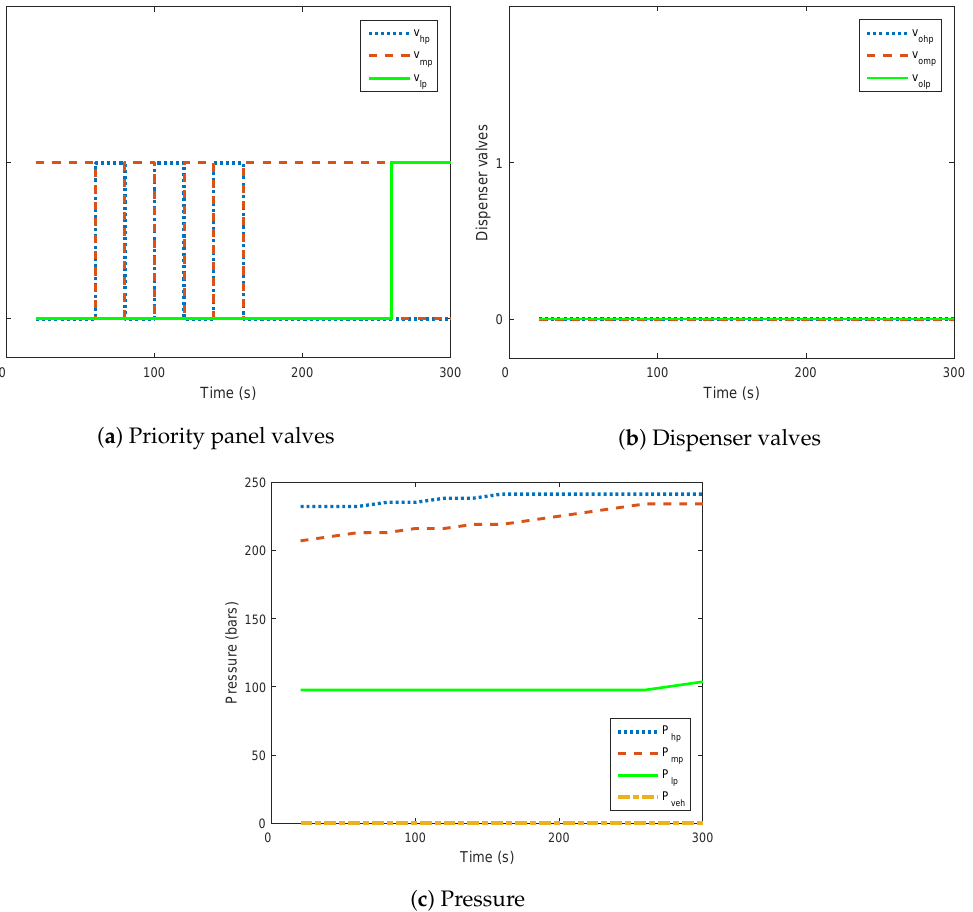
Figure 9. Compressor operation without vehicle being